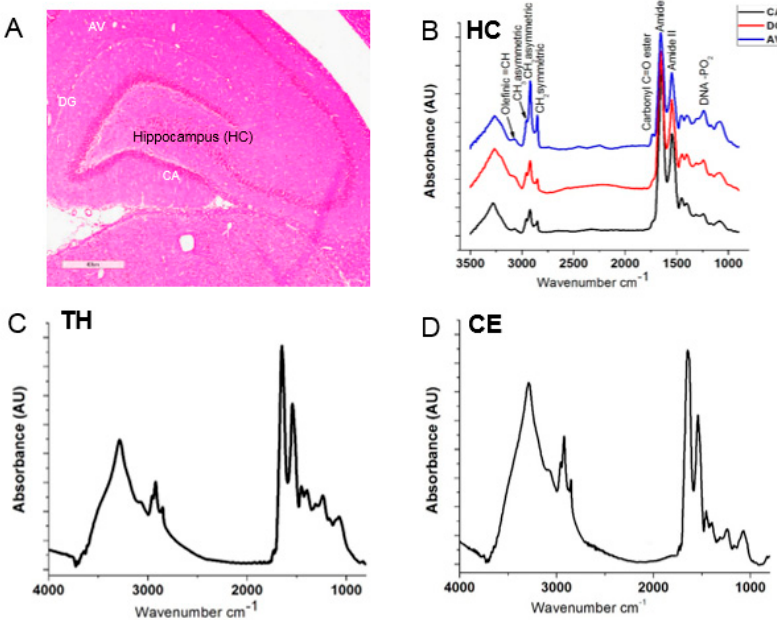
Figure 4. ( A ) H&E image of the Hippocampus showing AV, DG, and CA. ( B ) FTIR spectra of these three regions. ( C , D ) Representative FTIR spectra of TH and CE, respectively.